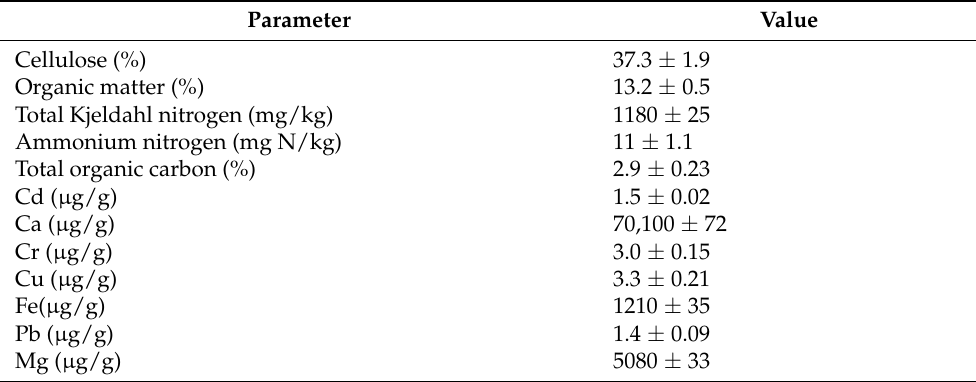
Table 1. Results of industrial waste